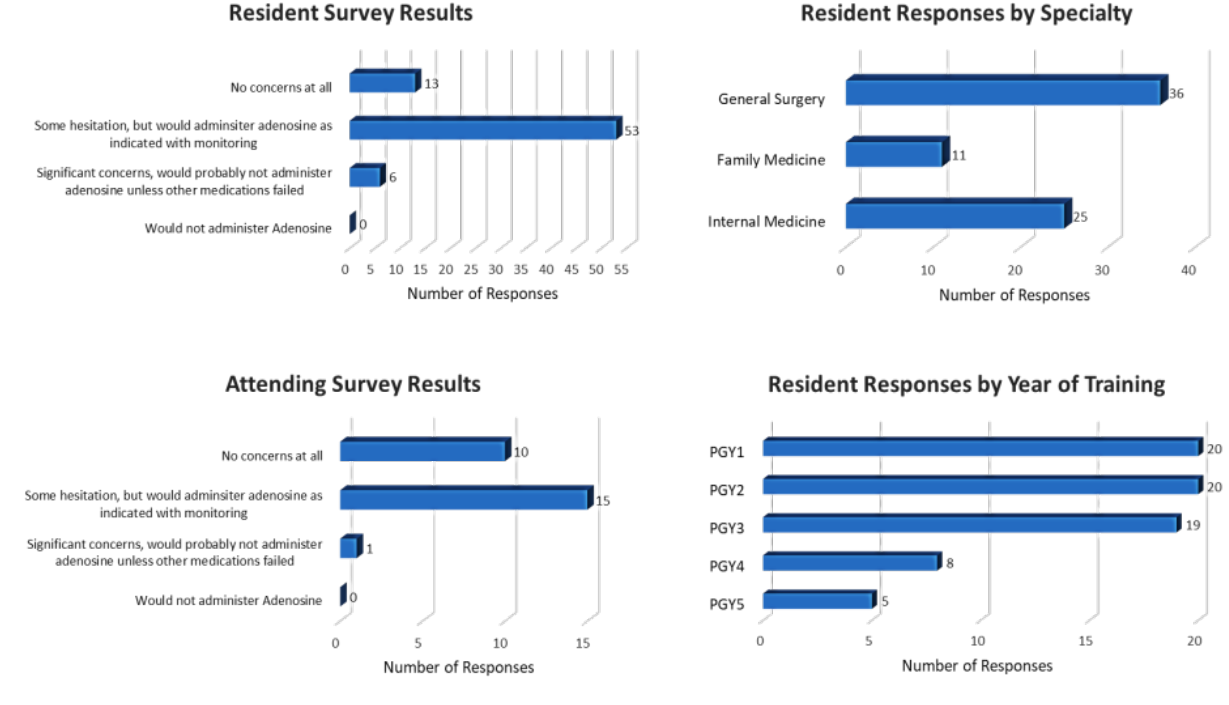
Figure 2. Survey Figure 2. Survey results.